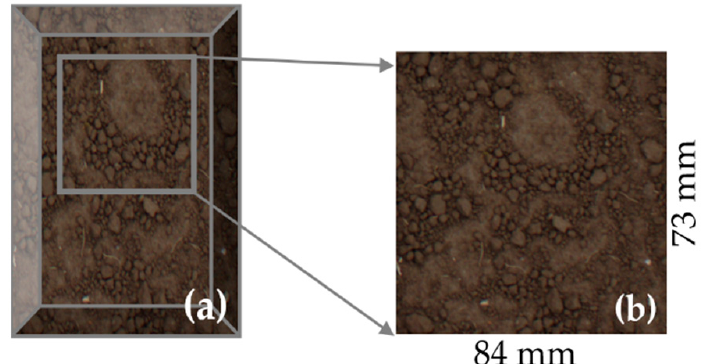
Figure 2. Example of an image selected for analysis. In order to avoid shadow, the VNIR image was selected from the upper ( a ) part of the tray. The image subset of 84 × 73 mm 2 with a pixel size of 2.4 mm / pixels ( b ) was obtained.